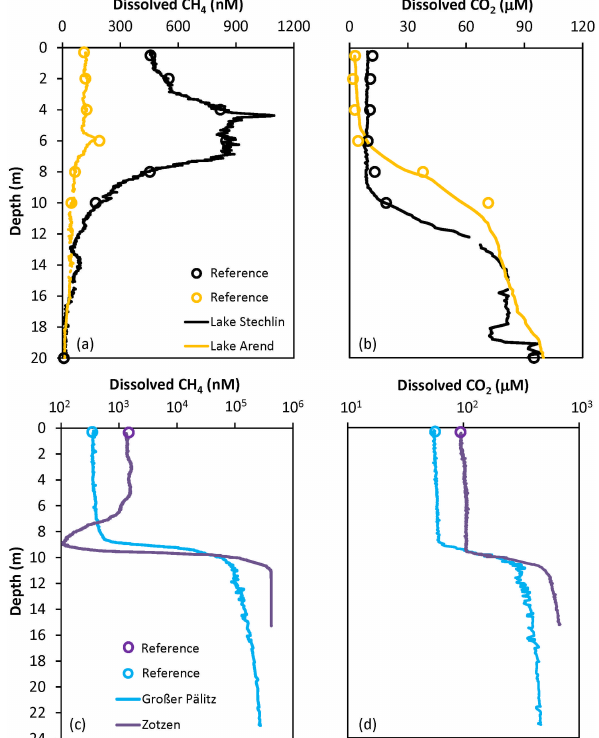
Figure 4. Depth profiles of dissolved CH 4 and CO 2 concentration from a set of lakes in Germany: (a, b) Lake Stechlin and Lake Arend with an oxygenated hypolimnion in summer; (c, d) Lake Großer Pälitz and Lake Zotzen, both with an anoxic hypolimnion in Oc- tober. Note that the log-transformed x axis is used in (c, d) . Refer- ences using the headspace method are designated as red open circles and measurements using the FaRAGE are shown as solid